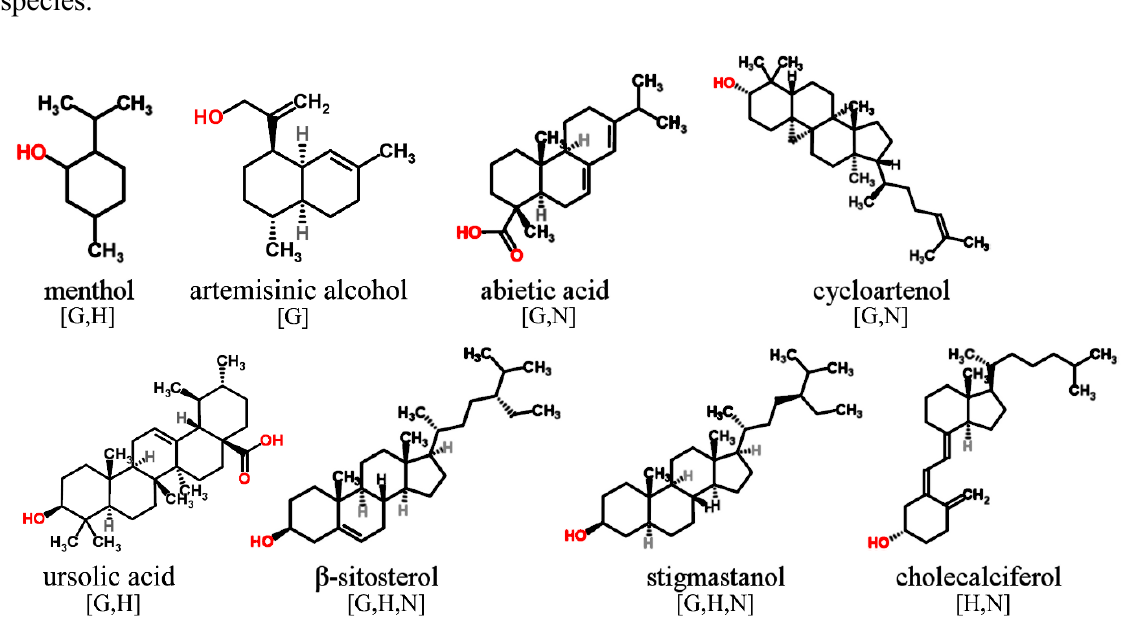
Figure 4. Terpenoids and sterols detectable in GC-MS profiling experiments. MS spectra included in publically available